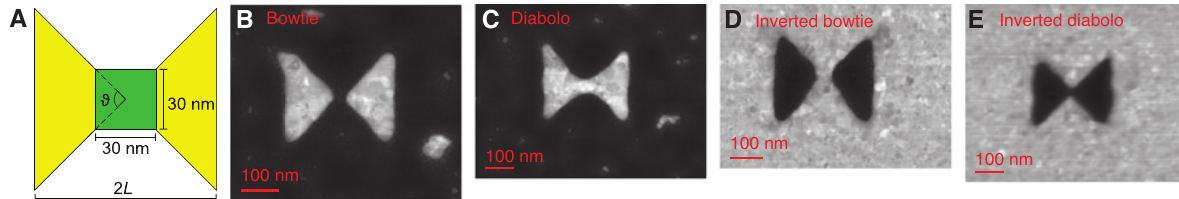
Figure 1: Bowtie and diabolo plasmonic antennas. (A) Schematic representation of the bowtie and diabolo antennas: wings (yellow), bridge (green). L denotes the length of the wing. (B–E) High-angle annular dark field (HAADF) images of (B) bowtie, (C) diabolo, (D) inverted bowtie, and (E) inverted diabolo antennas. Bright/dark colour corresponds to gold/substrate,